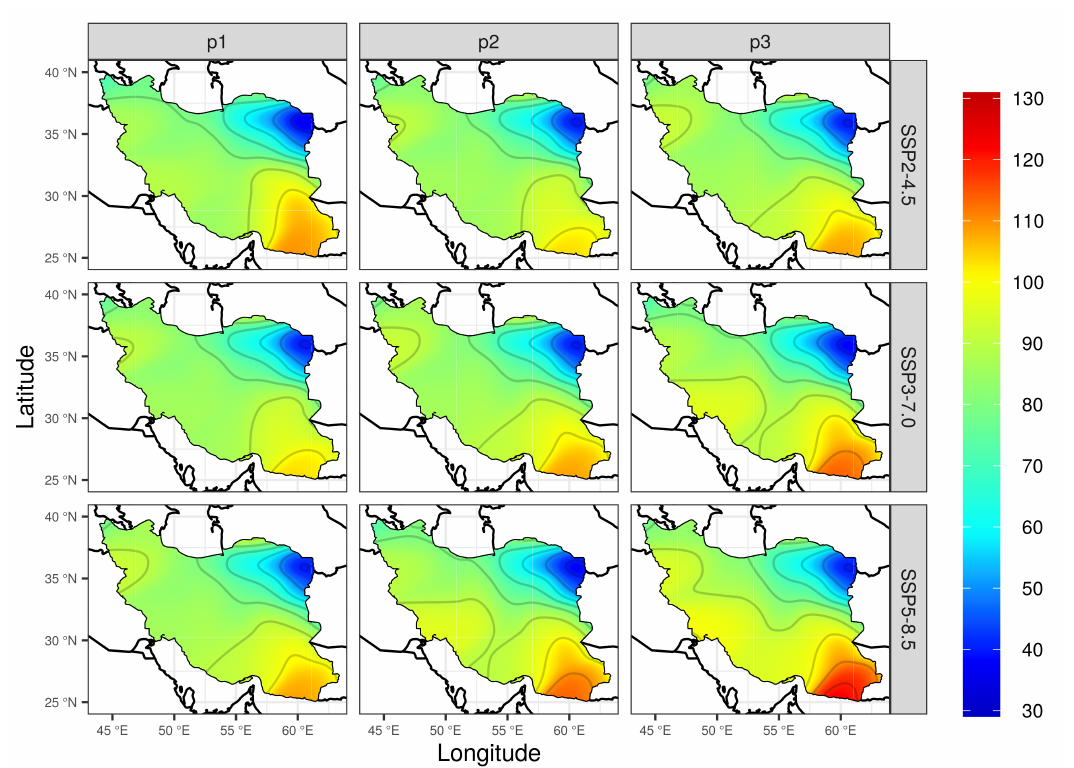
Figure 6. Isopluvial maps of the 50-year return levels (unit: mm) of the annual largest daily rainfall for 47 grids over Iran for the future periods, namely, P1 (2021–2050), P2 (2046–2075), and P3 (2071–2100) under the SSP2-4.5, SSP3-7.0 and SSP5-8.5